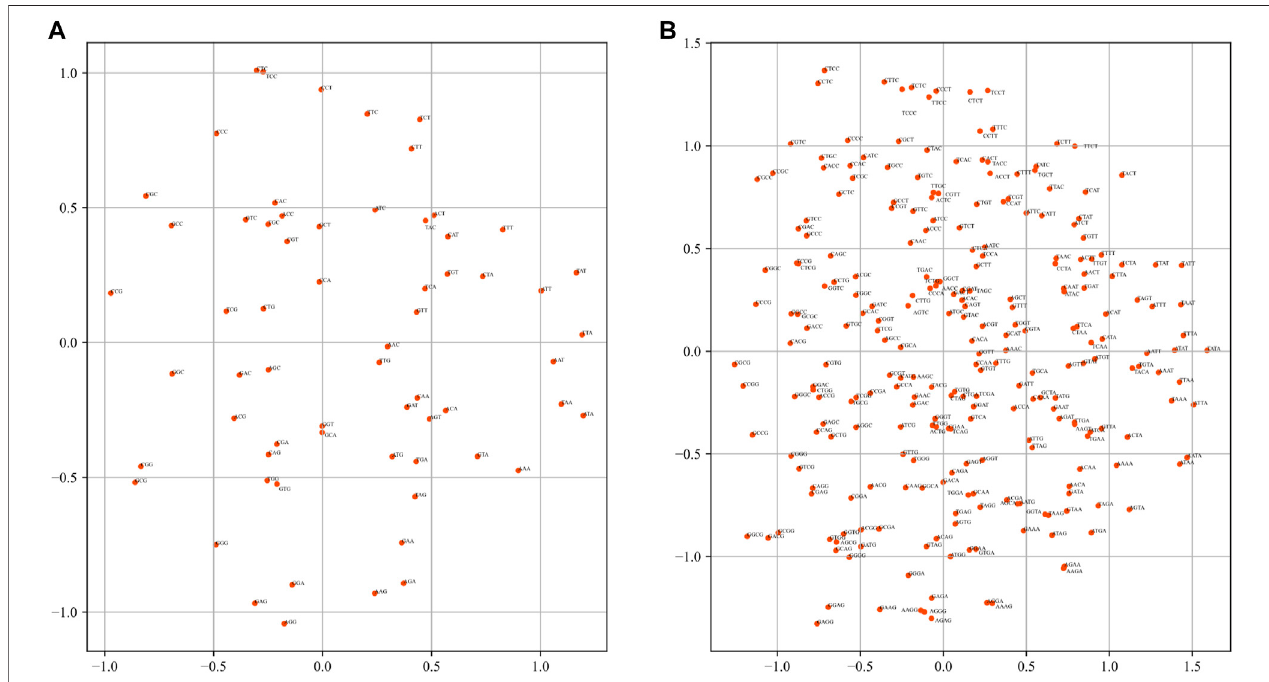
FIGURE 4 | Visualization of k -mer embeddings with PCA. Each dot represents a k -mer embedding vector. (A) 3-mer embedding. (B) 4-mer embedding.